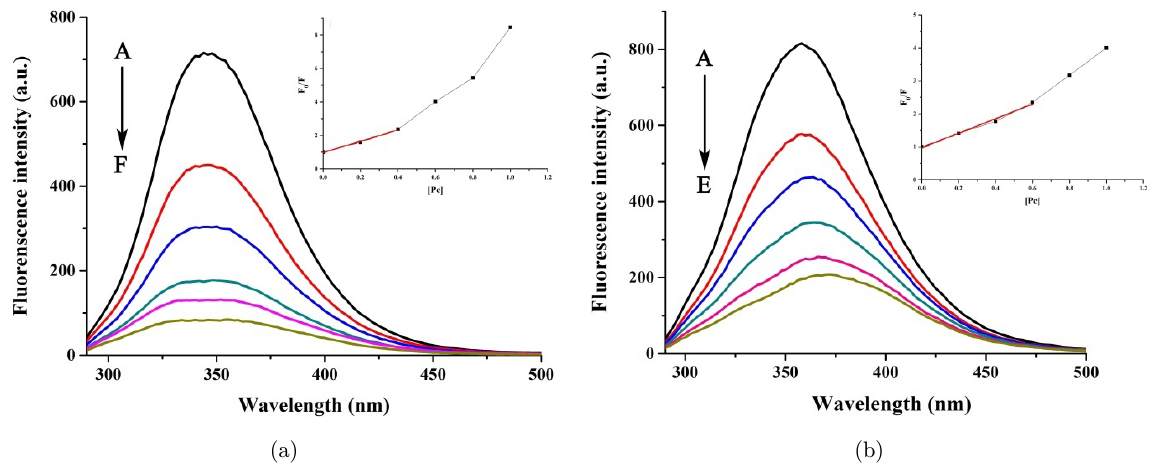
Fig. 3. Fluorescence spectra of BSA (a) and HSA (b) in PBS in the presence of di®erent concentration of AlPc: A (black): 0; B (red): 0 : 2 (cid:1) 10 (cid:2) 5 ; C (blue): 0 : 4 (cid:1) 10 (cid:2) 5 ; D (dark cyan): 0 : 6 (cid:1) 10 (cid:2) 5 ; E (pink): 0 : 8 (cid:1) 10 (cid:2) 5 ; F (green): 1 : 0 (cid:1) 10 (cid:2) 5 M. Insets: Stern – Volmer plots of °uorescence quenching of BSA and HSA versus AlPc complex concentration.